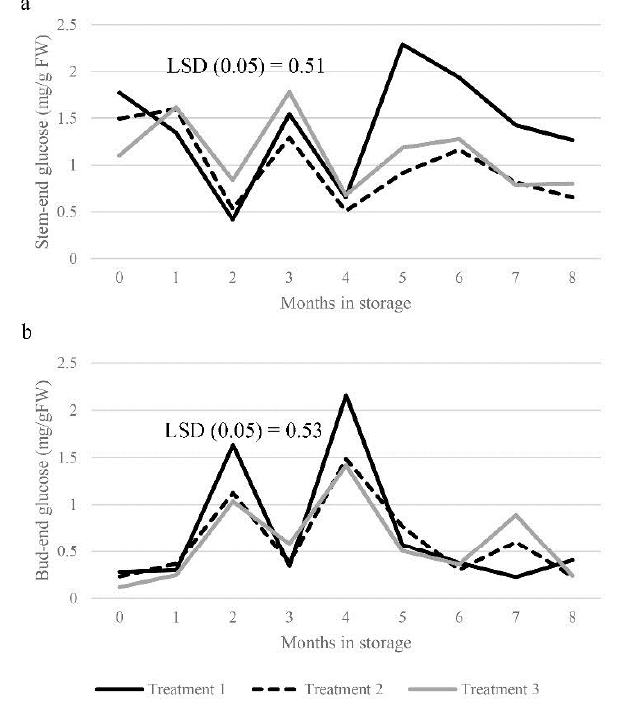
Figure 8. Stem-end glucose content (mg / g Fresh Weight, a ) and bud-end glucose content ( b ) of Russet Burbank under the three wound-healing treatments in 2018.